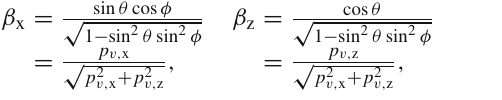
Fig. 3 Values of m (cid:3) normalised to m plotted as a function of log 10 γ T and ξ for θ = π/ 2 and φ = 0 (top) and θ = 0 . 9 and φ = 0 . 2 (bottom). In the top figure the boundary of the dark blue region, in which m (cid:3) is given by Eq. (10). With the values θ and φ used in the bottom figure, the value of m T / m in the δ rest frame is equal to sin θ = 0 .